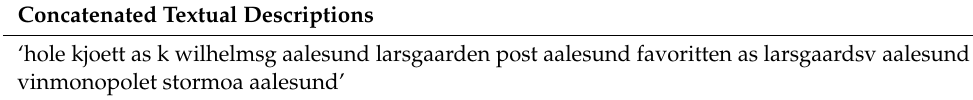
Table 4. Concatenated textual descriptions. Concatenated Textual